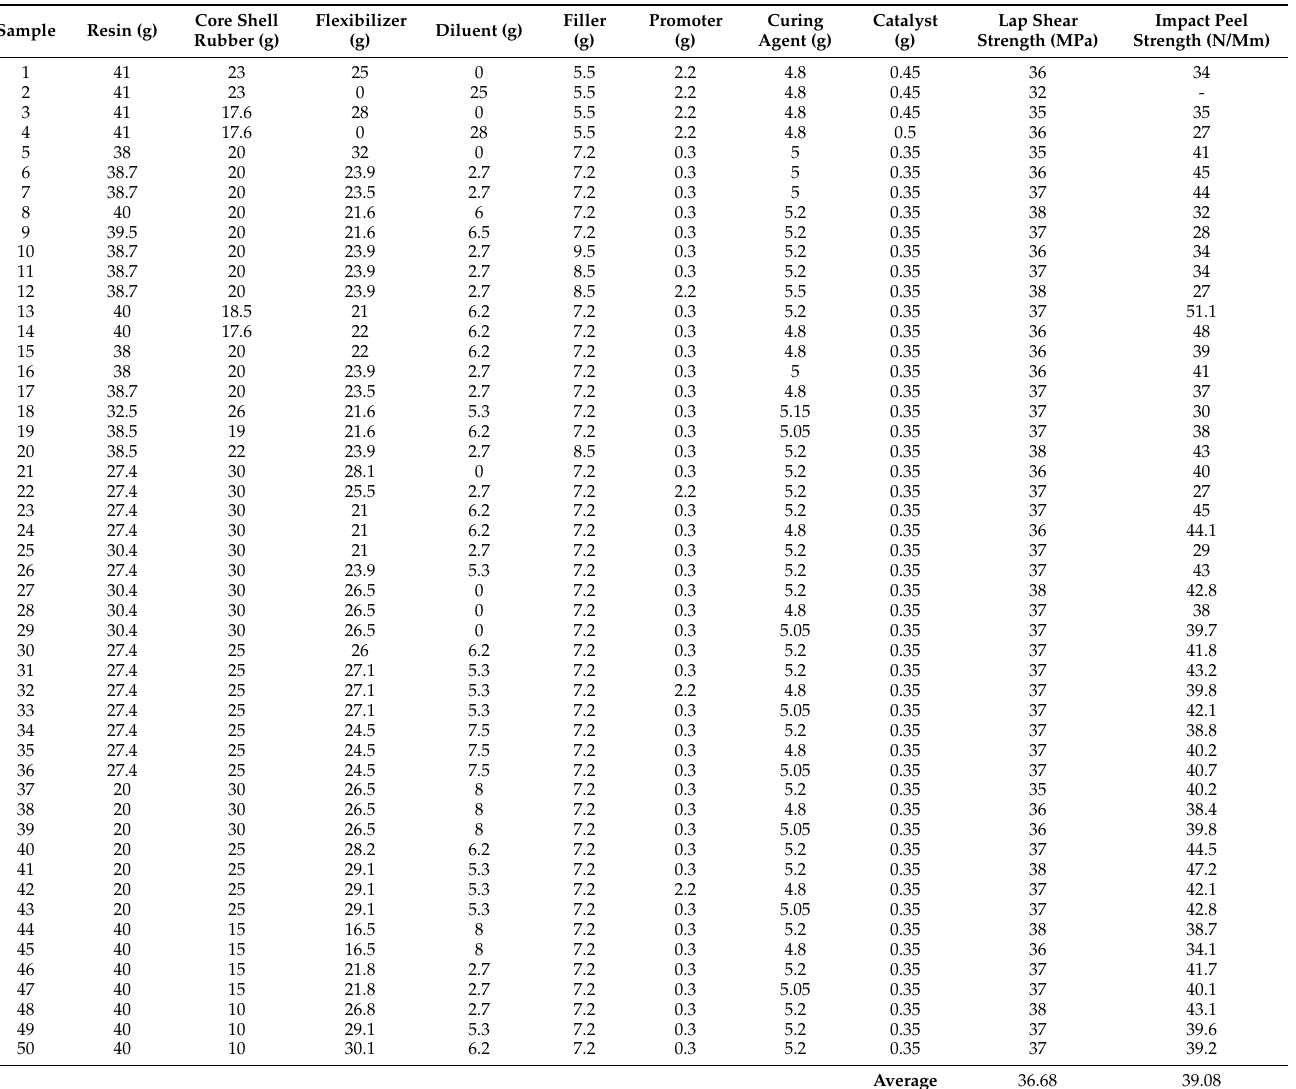
Table 1. Data set from adhesion test for machine